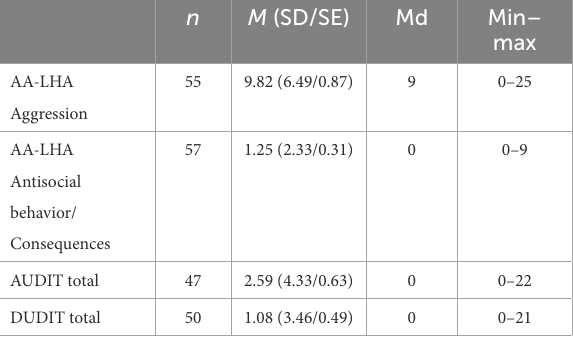
AA-LHA, Adolescent Adjusted Life History of Aggression; AUDIT, Alcohol Use Disorder Identification Test; DUDIT, Drug Use Disorder Identification Test, M , Mean; Md, Median; SD, standard deviation; SE, standard error.